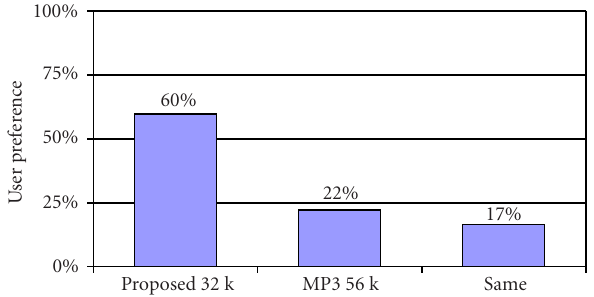
Figure 4: Listener preferences between the proposed algorithm at 32 kbit/s and MP3 at 56kbit/s. Note that while the proposed algo- rithm was used at almost 1 / 2 the bit rate of MP3, a large majority of listeners preferred it to the higher bit rate